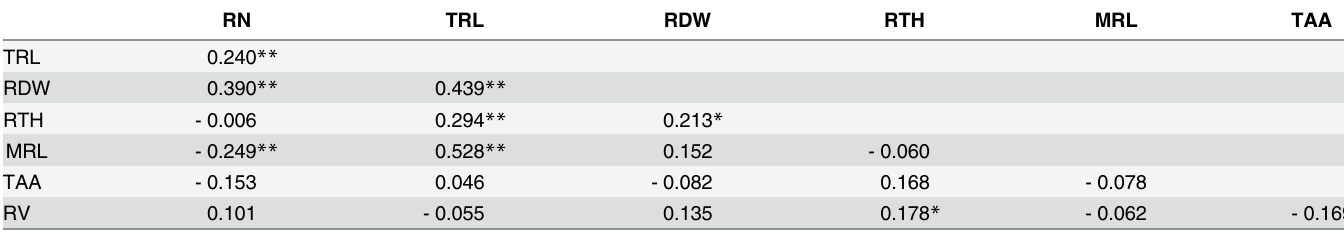
Table 2. Correlation coefficients among seven root traits in CSSLs.